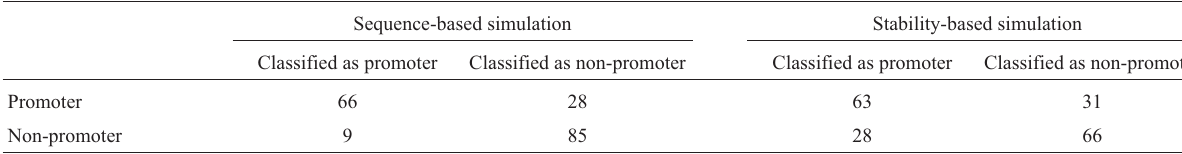
Table 1 - Confusion matrix for the NN architecture described in the text. The sequences were classified as promoters and non-promoter (random) se- quences.